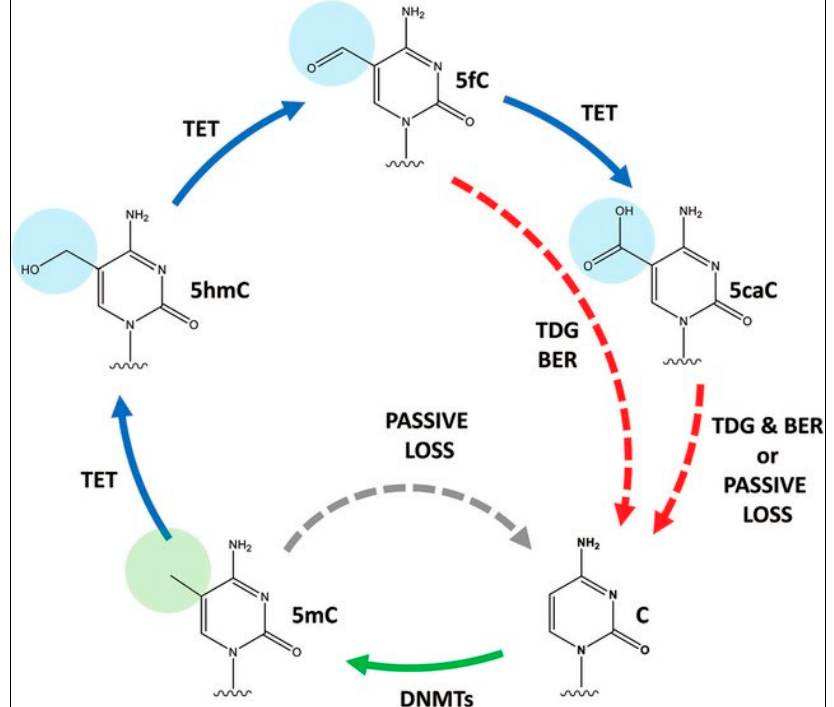
Figure 3. Cytosine methylation and demethylation cycle. C, cytosine; 5mc, 5-methylCytosine; 5hmC, 5-hydroxymethylCytosine; 5fc,5-formylCytosine; 5caC, 5-carboxylCytosine, TDG, thymine-DNA glycosylase; BER, Base Excision Repair, TET, Ten-Eleven Translocases, DNMT, DNA Methyltransferases. Reproduced with permission from Ravichandran M, Jurkowska RZ, Jurkowski TP. Target specificity of mammalian DNA methylation and demethylation machinery. Org Biomol Chem. 2018 Feb 28;16(9):1419-1435. doi: 10.1039/c7ob02574b. PMID: 29265160. [48]